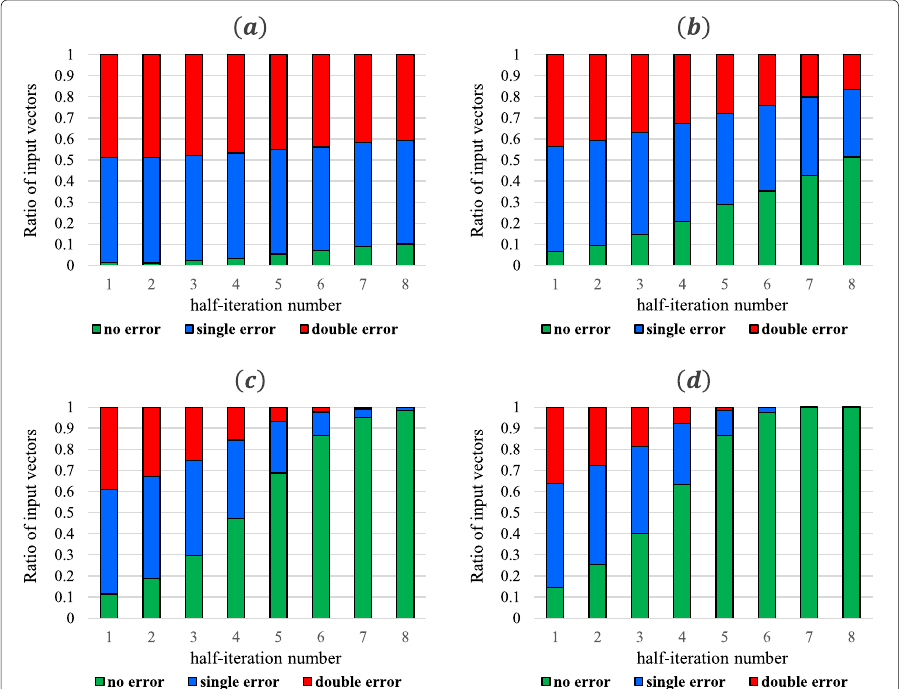
Fig. 5 Ratios of input vectors detecting each syndrome (green: no-error, blue: single-error, red: double-error) in the ( 64,57,4 ) 2 TPC according to the SNR regions when error correction is performed based on the Chase-Pyndiah algorithm. a SNR 1.0 dB corresponding to BER 10 − 1 . b SNR 2.75 dB corresponding to BER 10 − 2 . c SNR 3.25 dB corresponding to BER 10 − 4 . d SNR 3.5 dB corresponding to BER 10 −